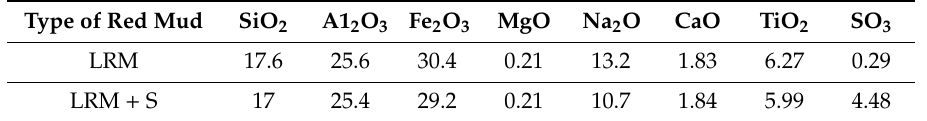
Table 2. Chemical composition of red mud.